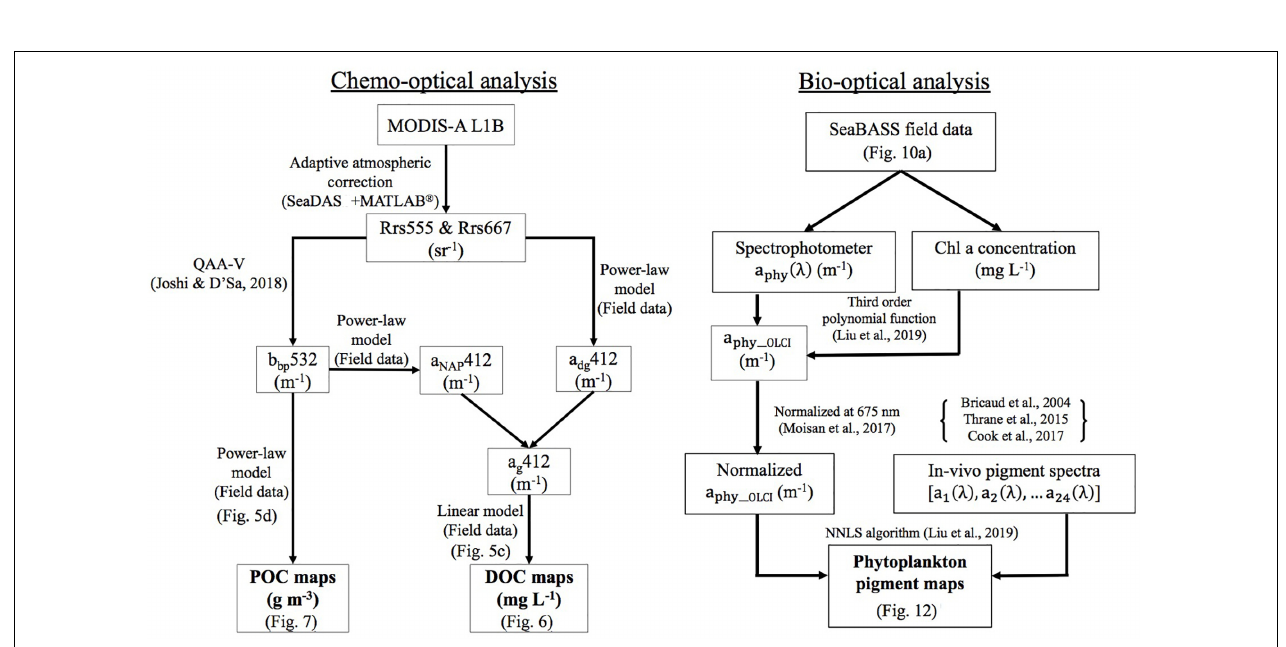
FIGURE 4 | Schematic diagrams. Processing pathways ( left panel: chemo-optical analysis) for generation of DOC and POC maps of ApB from MODIS imagery and ( right panel: bio-optical analysis) for generation of Chl a and phytoplankton pigment maps of the northwest Florida shelf waters from Sentinel-3 OLCI imagery.